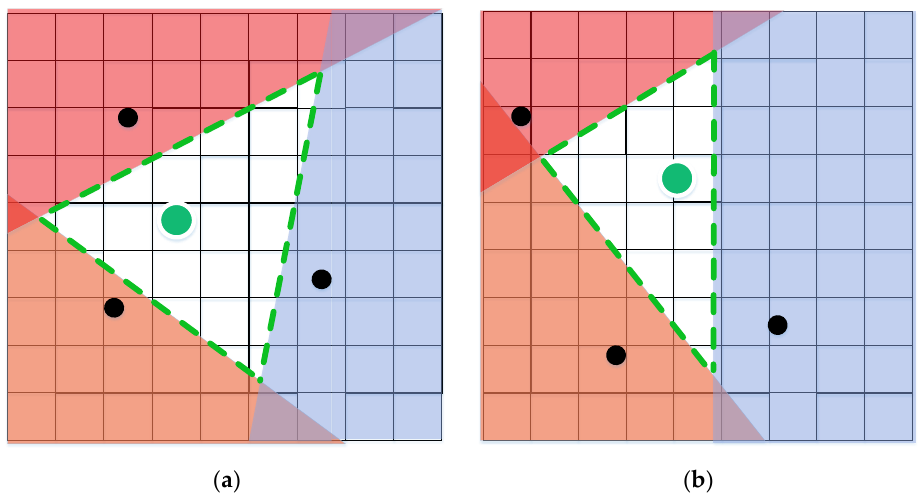
Figure 5. Construction of dynamic-layer corridor, ( a ) dynamic- layer corridor, ( b ) update of the dynamic-layer corridor